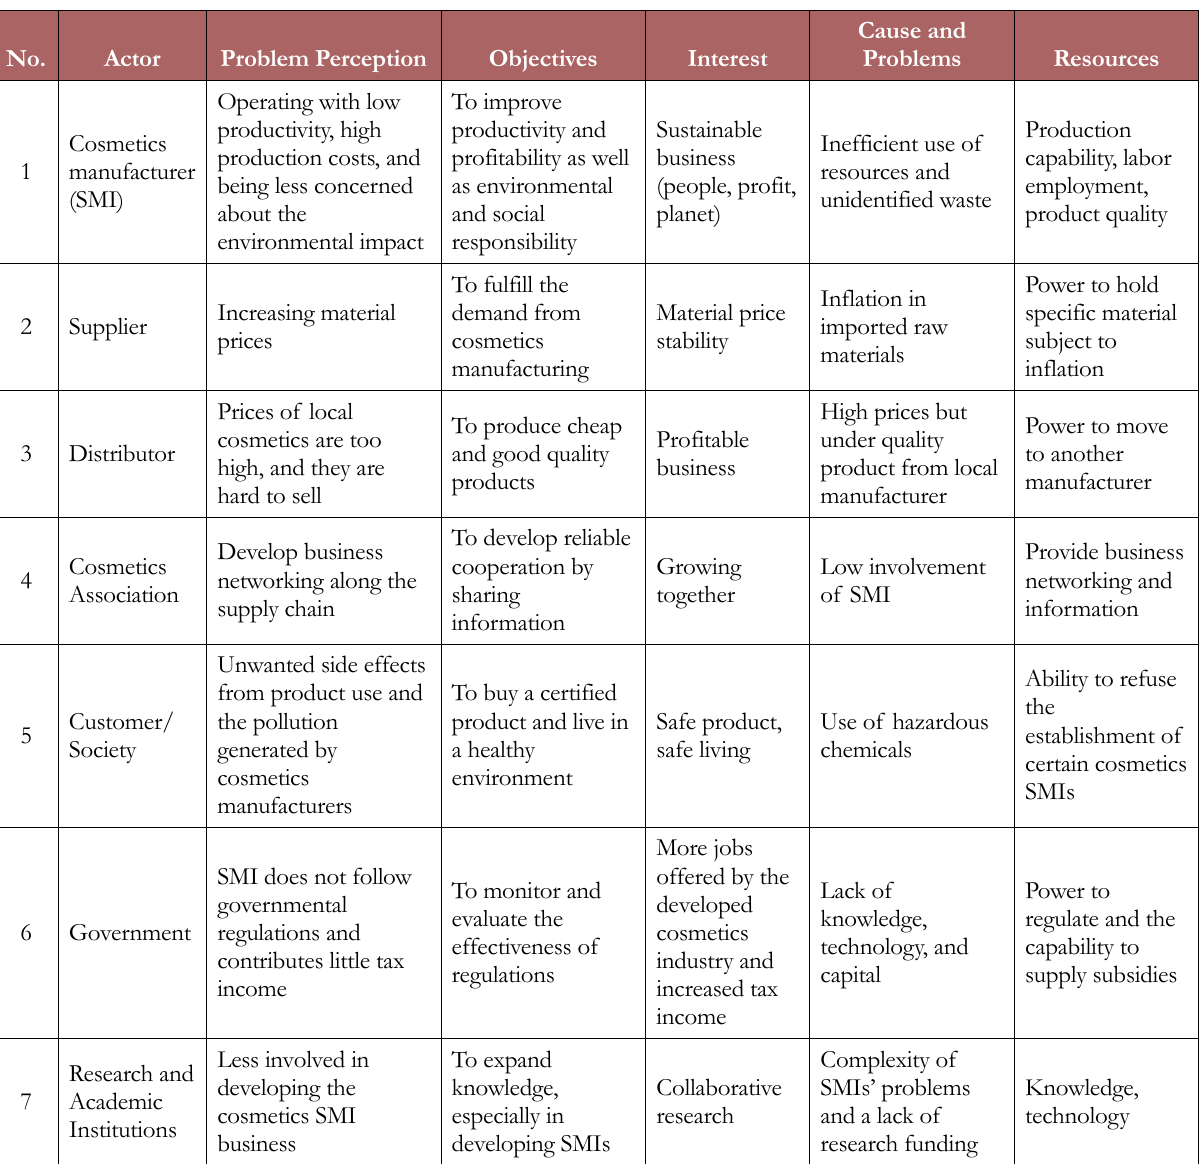
Table 2. Multi-Actor Analysis of Cosmetics Industry SMI Processes